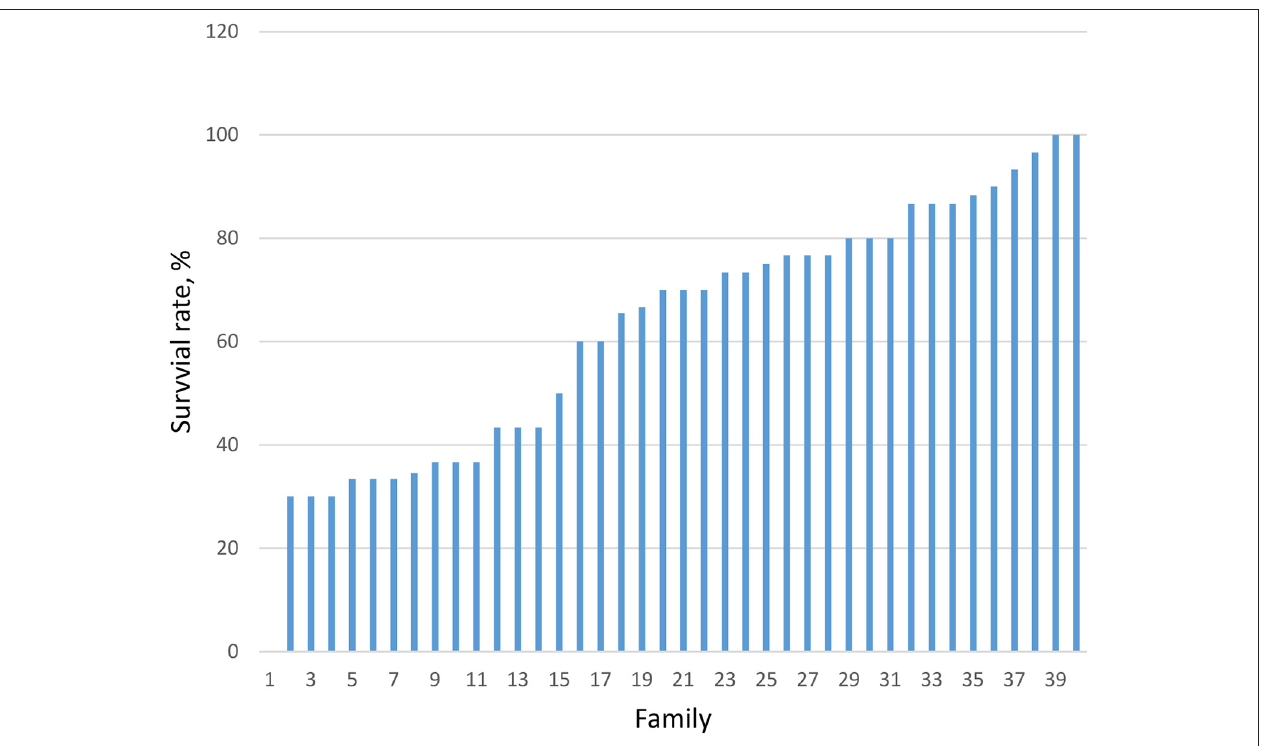
FIGURE 1 | Variation in survival rate among 40 families produced in 2015 ( P < 0.001).